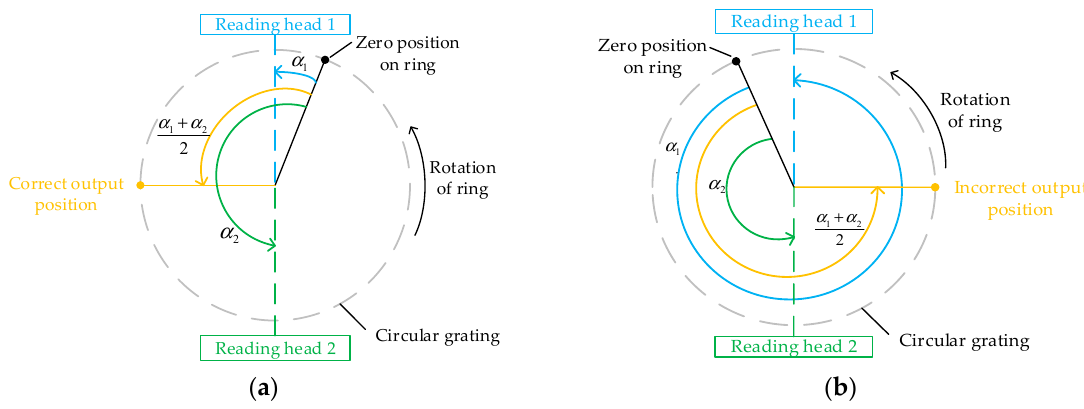
Figure 4. Double reading heads angle synthesis algorithm ( a ) α 1 ≤ α 2 , and ( b ) α 1 ＞ α 2 .